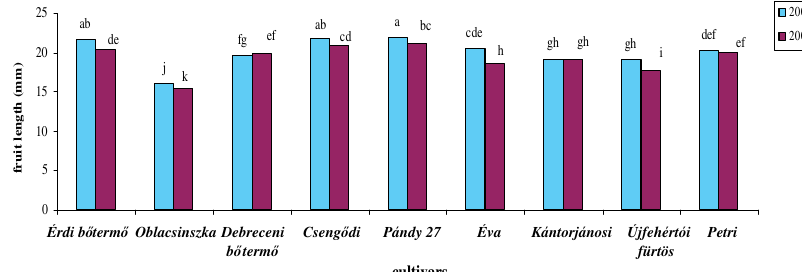
Figure 4. Fruit length of the studied sour cherry cultivars in tow years (2008 & 2009). Different letters indicate significant differences between treatments (P